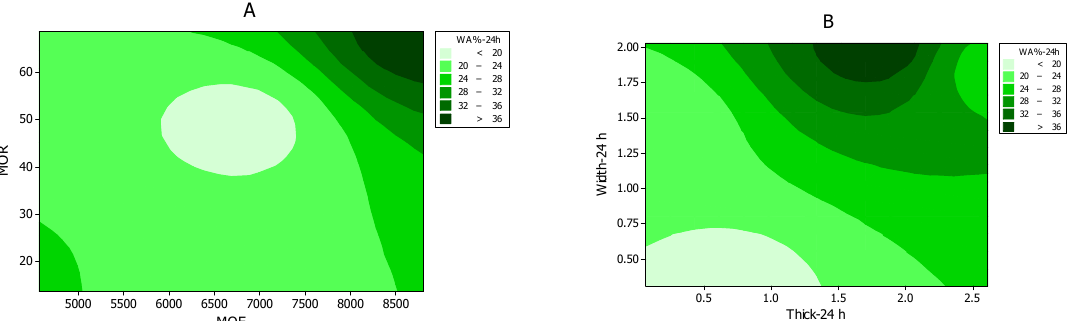
Figure 3. The HFM device with the attached thermocouples (green-cable edges at the yellow cir- cle) taking reading for a 72 h period.